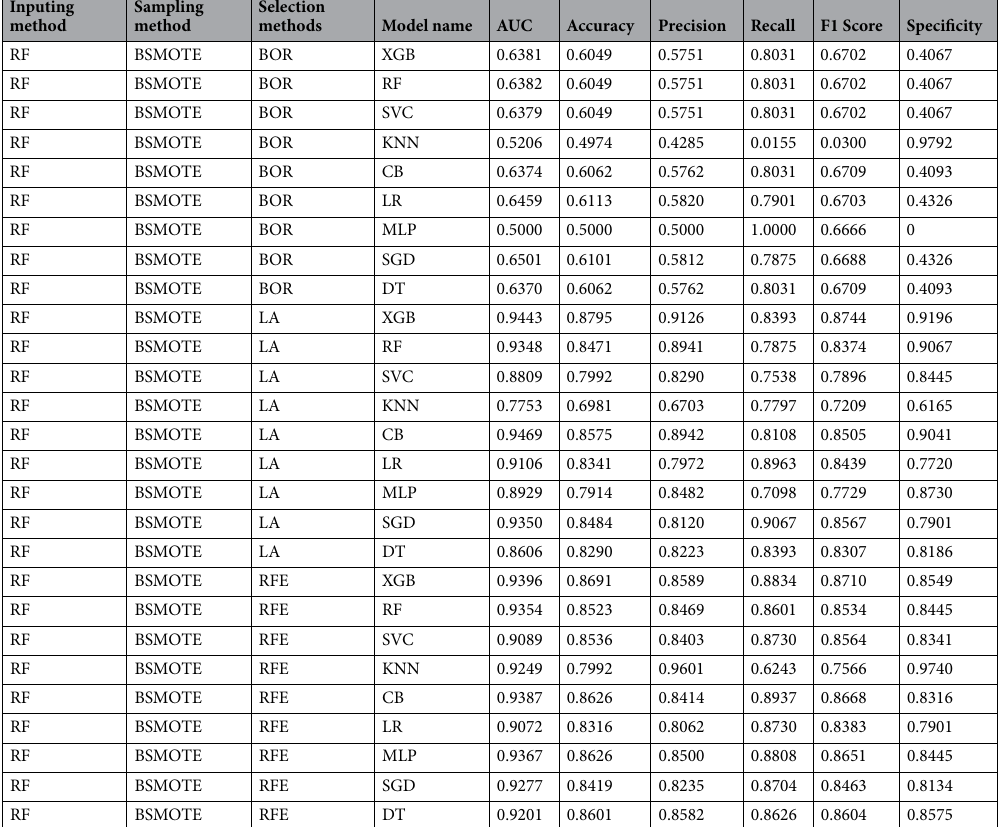
Table 1. The effect of different machine learning algorithms on model prediction performance using BSMOTE sampling method. BSMOTE borderline synthetic minority oversampling technique, BOR boruta screening, RFE recursive feature elimination, LA lasso screening, XGB extreme gradient boosting, SVC support vector classify, KNN K-nearest neighbor, CB category boosting, LR logistic regression, MLP multilayer perceptron, SGD stochastic gradient descent, DT decision tree, AUC area under the